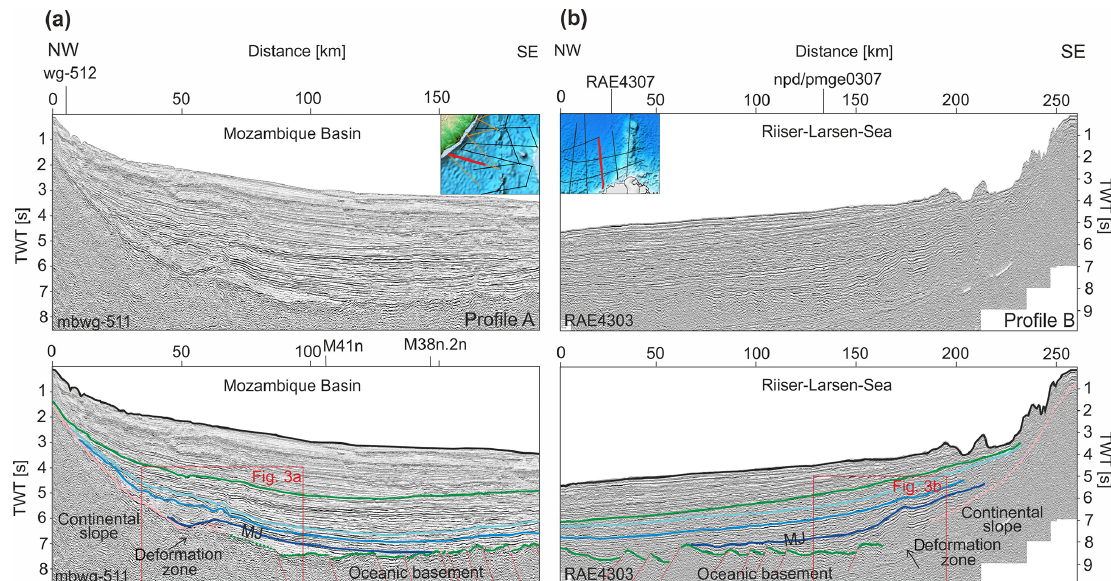
Figure 2. Migrated profile Mbwg00-511 in the Mozambique Basin (a) and stacked profile RAE4303 in the Riiser-Larsen Sea (b) (line locations in inset maps and Fig. 1). In the lower panels, the stratigraphic interpretation according to Castelino et al. (2015), Leitchenkov et al. (2008) and Mahanjane (2014) is presented. At the foot of the continental slope, at the continent–ocean transition, a 20–30km wide zone of deformed and fractured basement, is distinct. Post-rift sediments overlying the deformation zone have been affected by the deformation. This deformation zone is proposed as a tie point for Gondwana